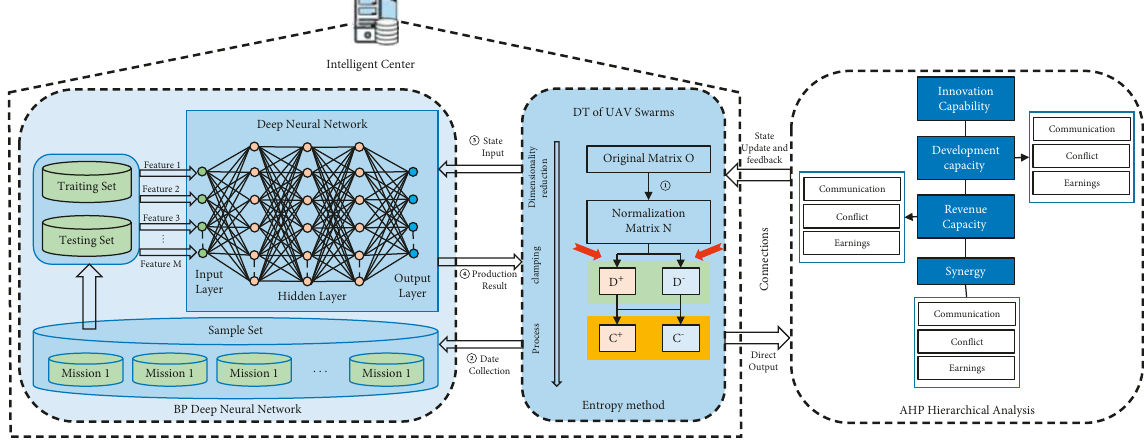
Figure 2: Block diagram of the double assignment evaluation